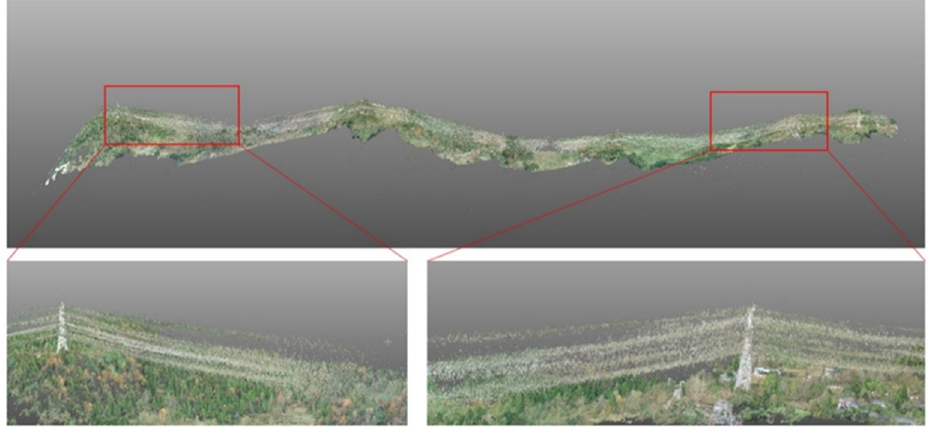
Figure 3. The influence of inaccurately estimated distortion parameters with dense matching for power lines.